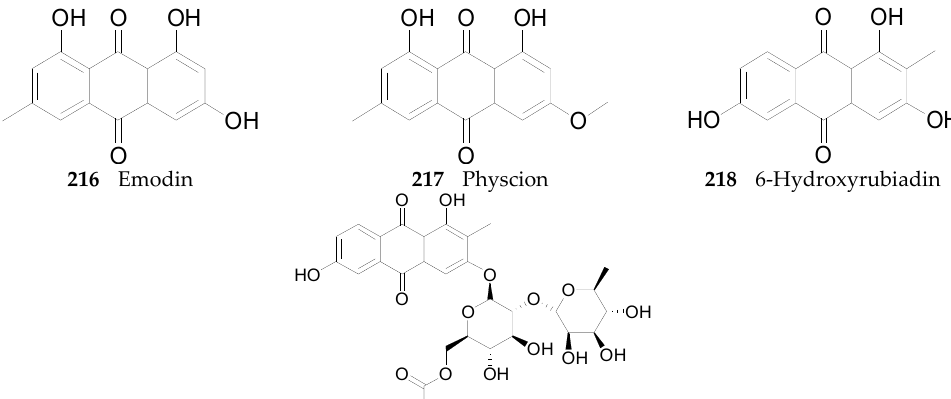
Figure 17. Chemical structures of compounds 216 – 219 .